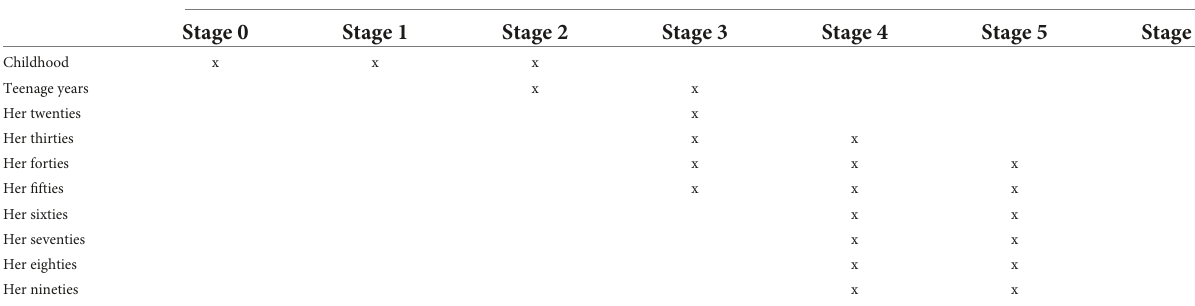
TABLE 2 Faith development (FD) in ESH’s